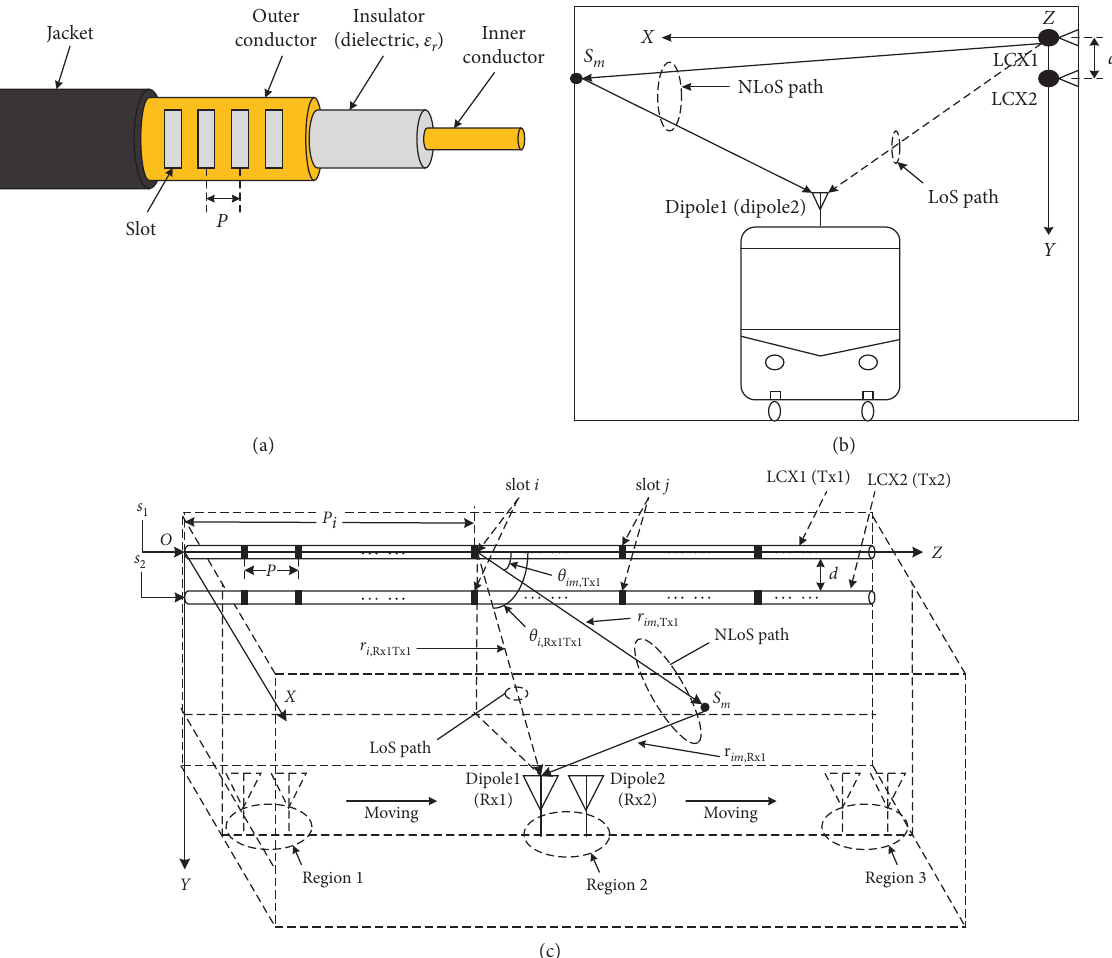
Figure 1: (a) LCX structure; (b) LCXs and dipoles installation; (c) signal propagation for LoS and NLoS path of LCX-MIMO transmission